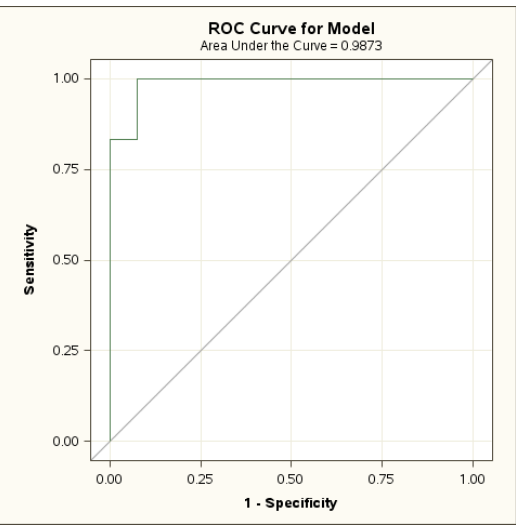
J. Clin. Med. 2023 , 12 , x FOR PEER REVIEW Figure 1. ROC curve and area under the curve (AUC) for basal 17-OHP. Figure 1. ROC curve and area under the curve (AUC) for basal 17-OHP.